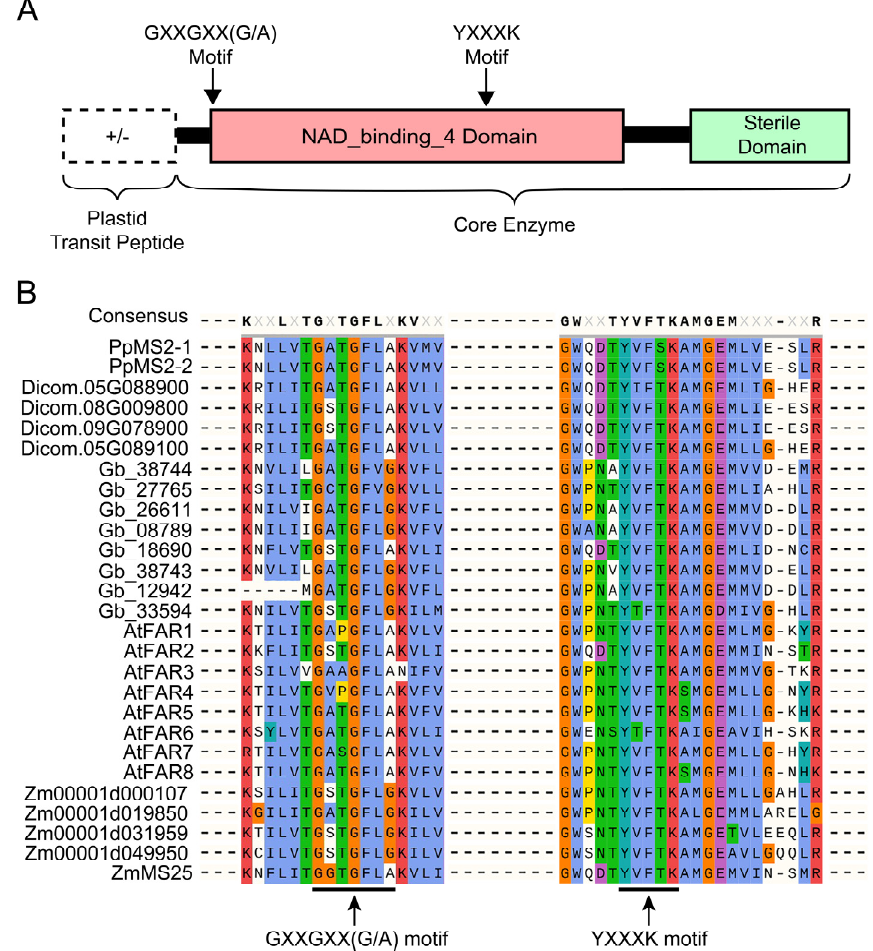
Figure 2. FAR proteins structural domains and protein sequence alignment of FARs from five model species. ( A ) Schematic representation of the structural domains of FAR proteins. NAD_binding_4 domain at the N − terminus is indicated in red, FAR_C domain at the C − terminus is indicated in green. ( B ) Multiple alignments of FAR proteins. The two conserved motifs (GXXGXX(G/A) and YXXXK, X represent any amino acid) within the NAD_binding_4 domains are indicated by black arrows.